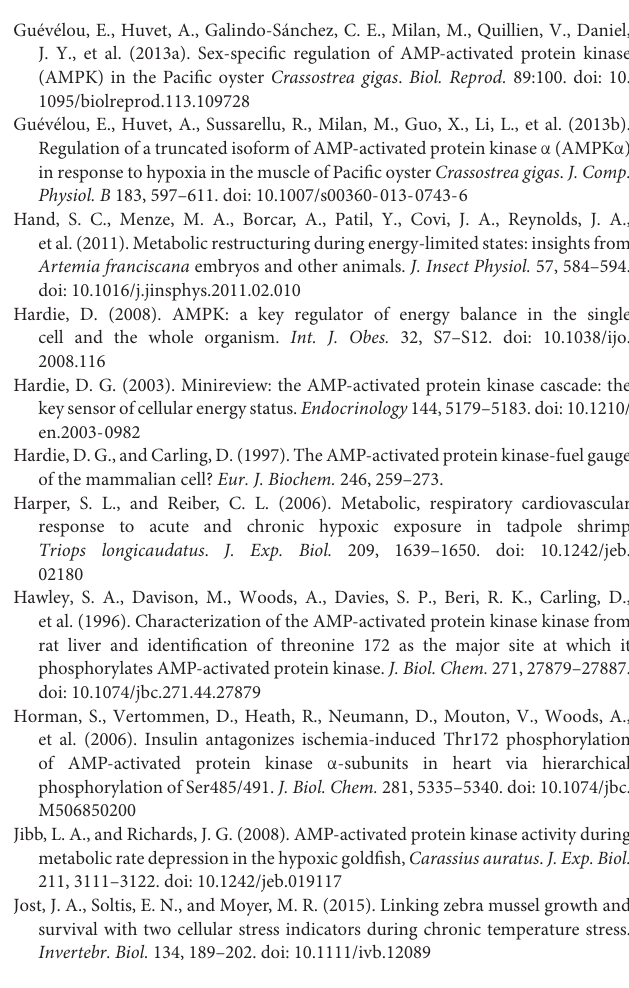
FIGURE S1 | The full-length cDNA of the AMPK α subunit gene of the oriental river prawn and the deduced amino acid sequence are shown. Uppercase letters indicate the translated region, lowercase letters indicate the untranslated region, and the asterisk indicates the stop codon. The protein kinase ATP-binding region signature is shaded, the serine/threonine protein kinase active-site signature is underlined, and the activation loop region signature is boxed. FIGURE S2 | The full-length cDNA of the AMPK β subunit gene of the oriental river prawn and the deduced amino acid sequence are shown. Uppercase letters indicate the translated region, lowercase letters indicate the untranslated region, and the asterisk indicates the stop codon. The glycogen binding site is shaded. FIGURE S3 | The full-length cDNA of the AMPK γ subunit gene of the oriental river prawn and the deduced amino acid sequence are shown. Uppercase letters